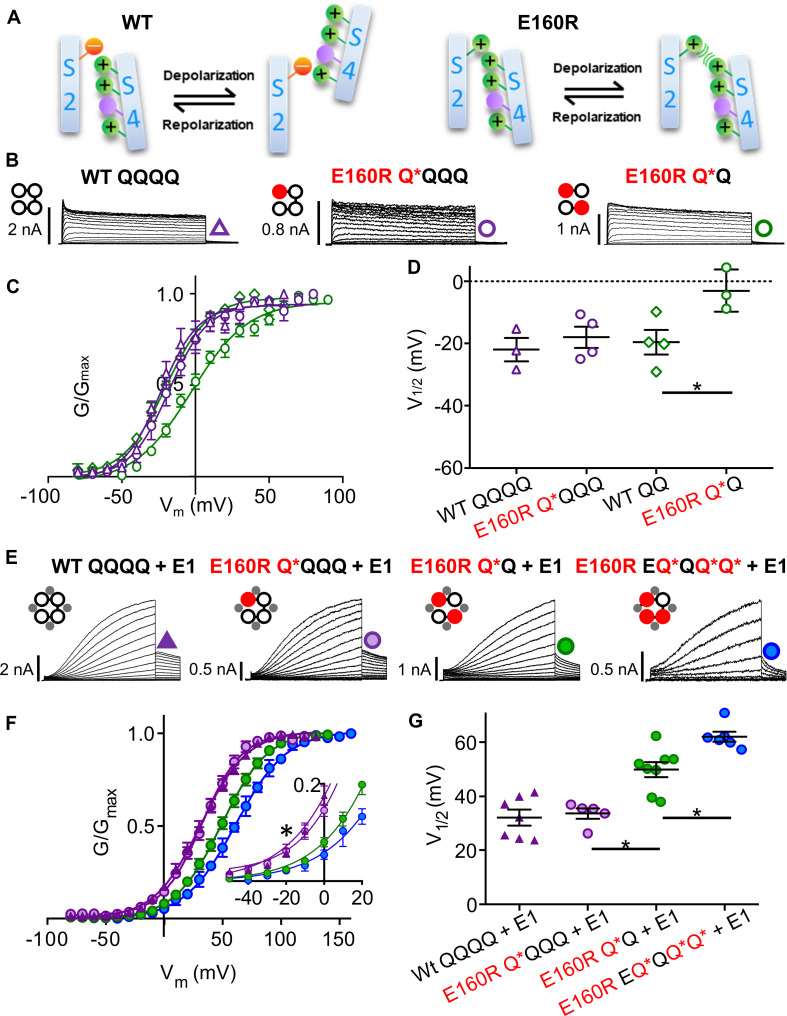
Functional currents from KCNQ1 and KCNQ1 + KCNE1 channel complexes with one, two or three E160R mutations (A) Cartoons representing possible charge interactions between WT S2 and S4 TMDs during activation and deactivation (left) and E160R mutants when VSD movement is impeded by charge repulsion (right). Channel topology configurations of WT Q1 (black) and E160R mutant (red) subunits, with E1 (gray) are shown adjacent to current traces (B,E). Black lines represent tethers between subunits. Currents were obtained using the same protocol as in Figures 1B–D. In the absence of KCNE1. Currents (B), mean G-V (C), and summary V1/2 of activation (D) for KCNQ1 complexes containing zero (WT QQQQ: purple triangles; WT QQ: green diamonds), one (E160R Q*QQQ; purple circles) or two (E160R Q*Q; green circles) E160R mutant subunits (n = 3–4; *p < 0.05). (E–G) In the presence of KCNE1. Currents (E), mean G-V (F) V1/2 of activation (G) for Q1 + E1 complexes containing zero (WT QQQQ; purple triangles), one (E160R Q*QQQ; purple circles), two (E160R Q*Q; green circles) or three (E160R EQ*QQ*Q*; blue circles) E160R subunits (n = 5–8; ∗p < 0.05). (E, Inset) Expanded view of G-V plots between –50 and +20 mV (∗p < 0.05). Figure adapted from Westhoff et al. (2019), Figures 1, 3.